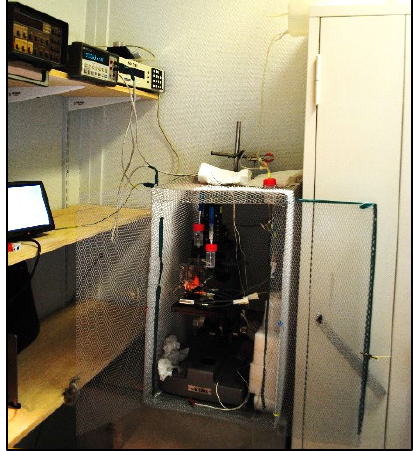
Figure 14. Photo of the appearance of the